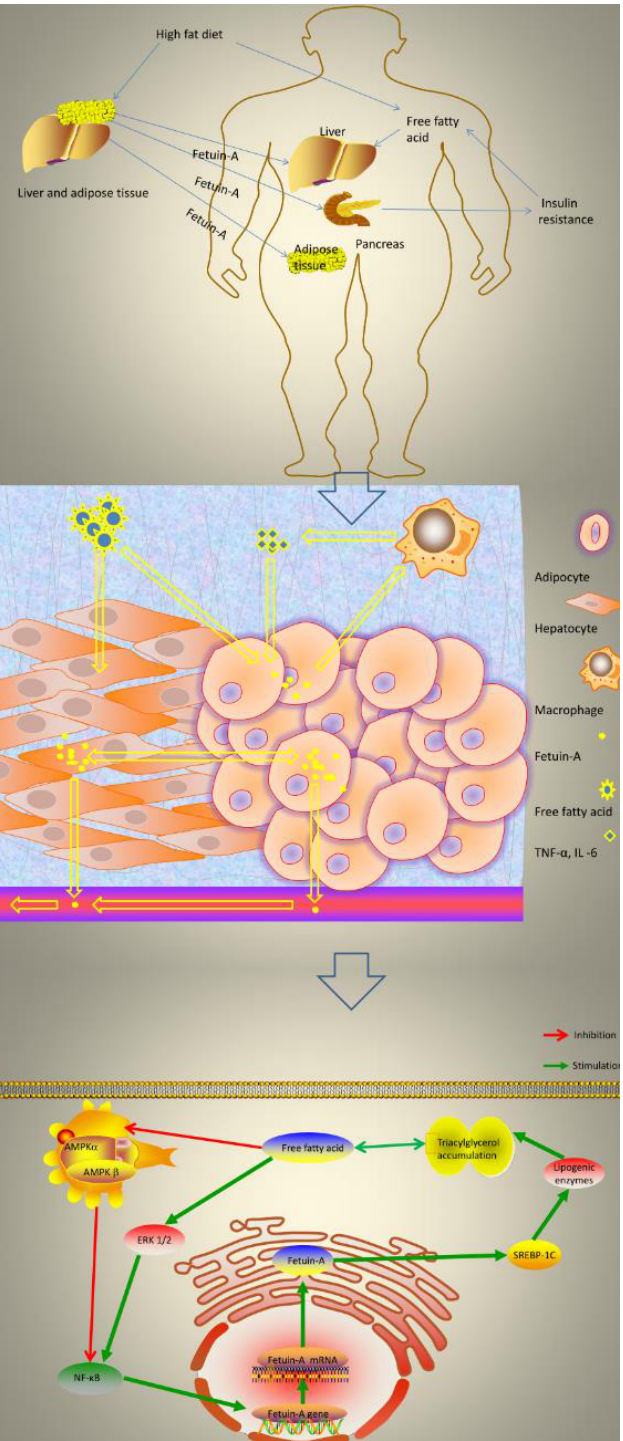
Asian population. In addition, Marhaug and colleagues found that fetuin-A levels were significantly higher in adult populations than in children and adolescents [48].